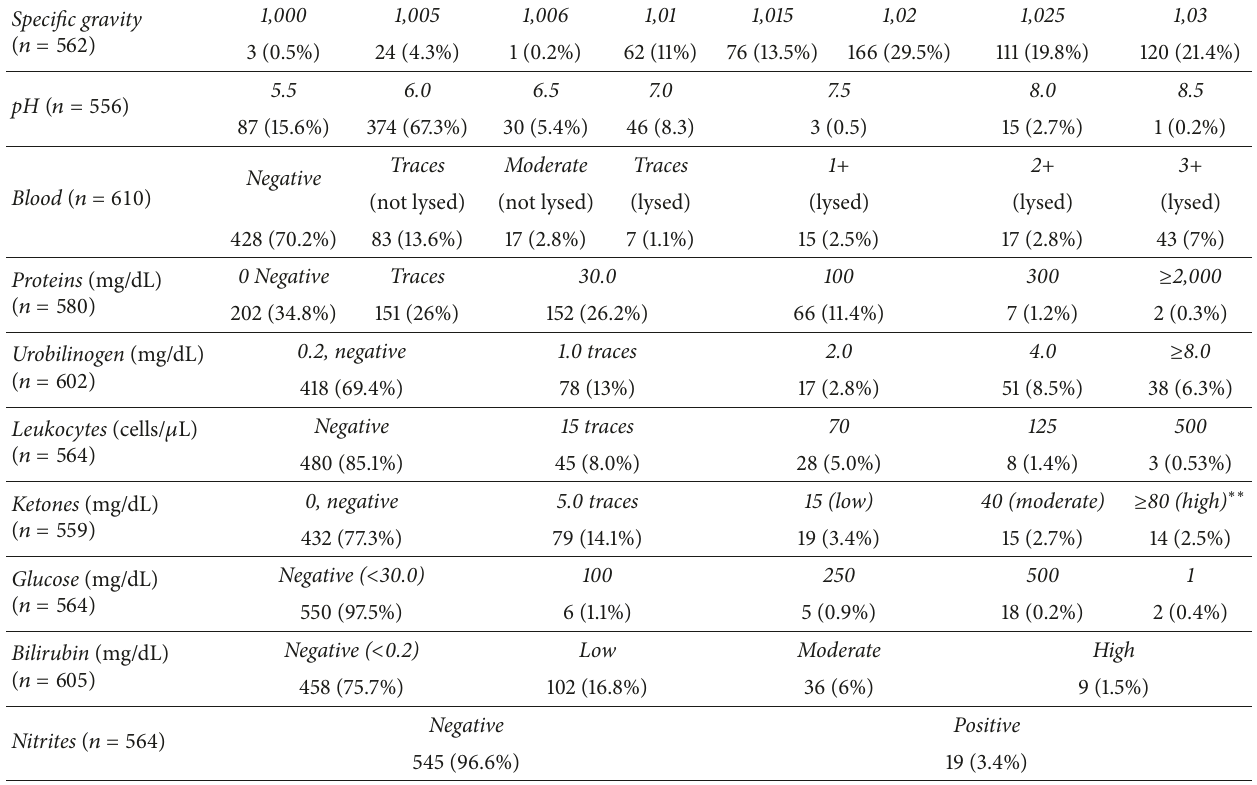
Table 2: Urinalysis test variables in 620 patients with malaria ∗